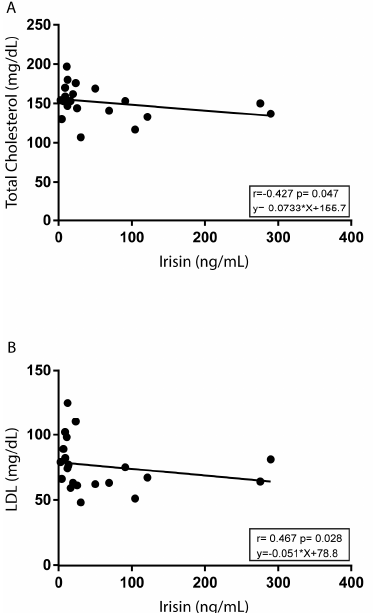
Figure 4. Correlations of irisin with total cholesterol and LDL in Group C. Association of irisin with total cholesterol ( A ) or LDL ( B ) were analyzed by Pearson’s correlation test. For each linear regression graph, the linear equation (y), the correlation coefficient ( r ), and the statistical significance (p) are reported. Finally, we analyzed the usefulness of anthropometric indices, body composition parameters, lipid profiles, and irisin as predictors of vigorous-intensity PA with respect to inactivity in adolescents (Group C vs. Group A). Table 4 shows AUC, optimal cutoffs, and measures of accuracy for irisin, LDL, and HDL values (AUC > 0.7), for BMI (AUC > 0.6) and selective body composition variables (AUC > 0.7). Particularly, FFM and TBW had the highest sensitivity (>90%), while irisin, BMC, and PhA showed the highest specificity (>80%). Table 4. Accuracy of irisin, lipid profile measures, anthropometric and body composition parameters as predictors of the intensity level of physical activity. Optimal Sensitivity (%) (95% Specificity (%) (95% p Characteristics AUC Cutoff C.I.) C.I.) Value Irisin (ng/mL) 0.705